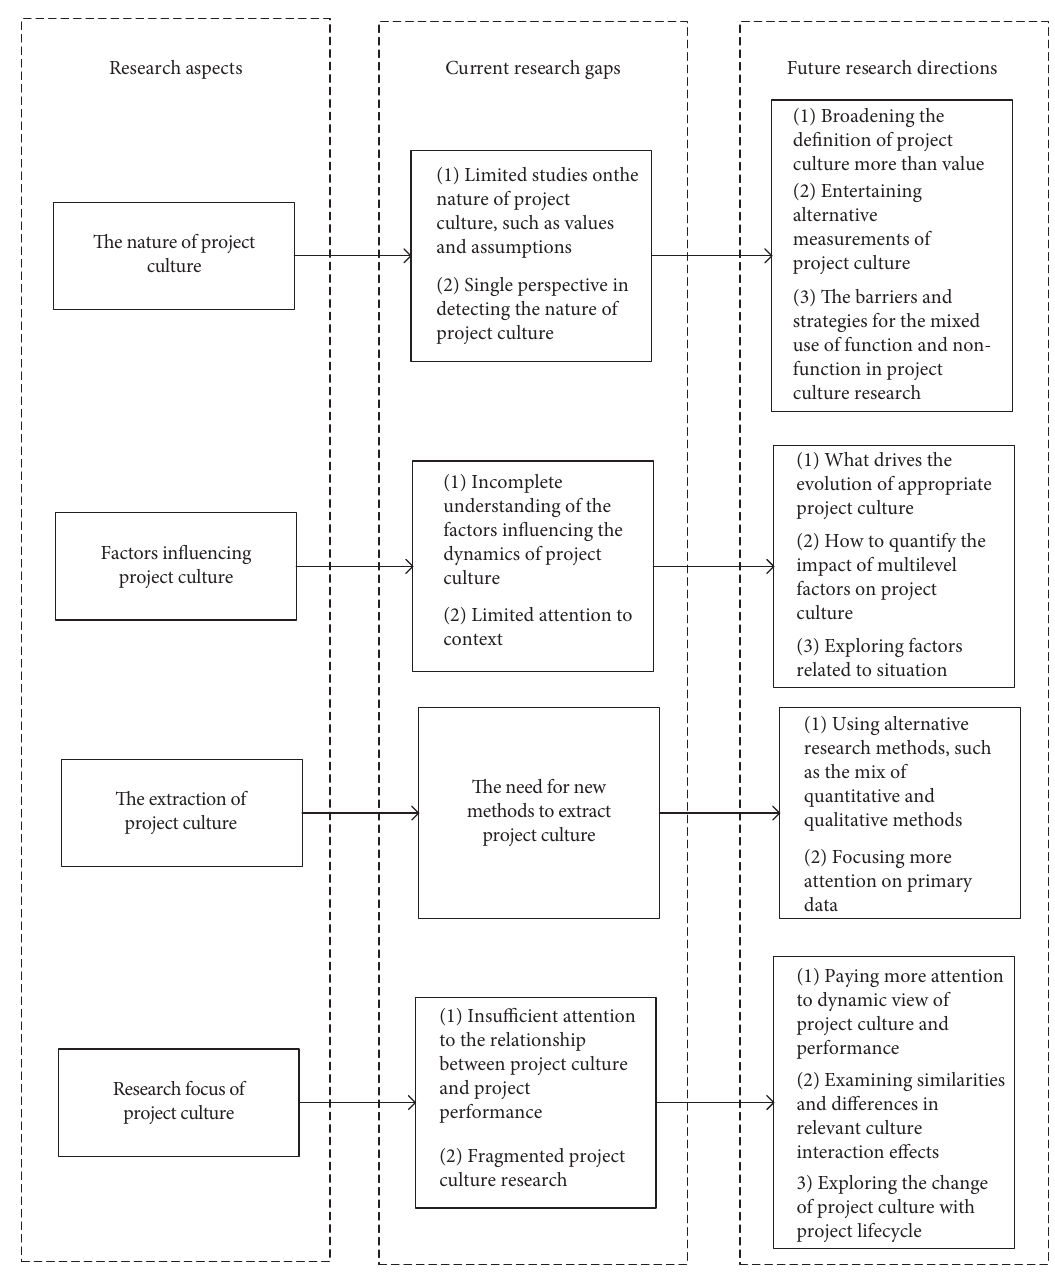
Figure 2: The framework of main research gaps and future directions of project